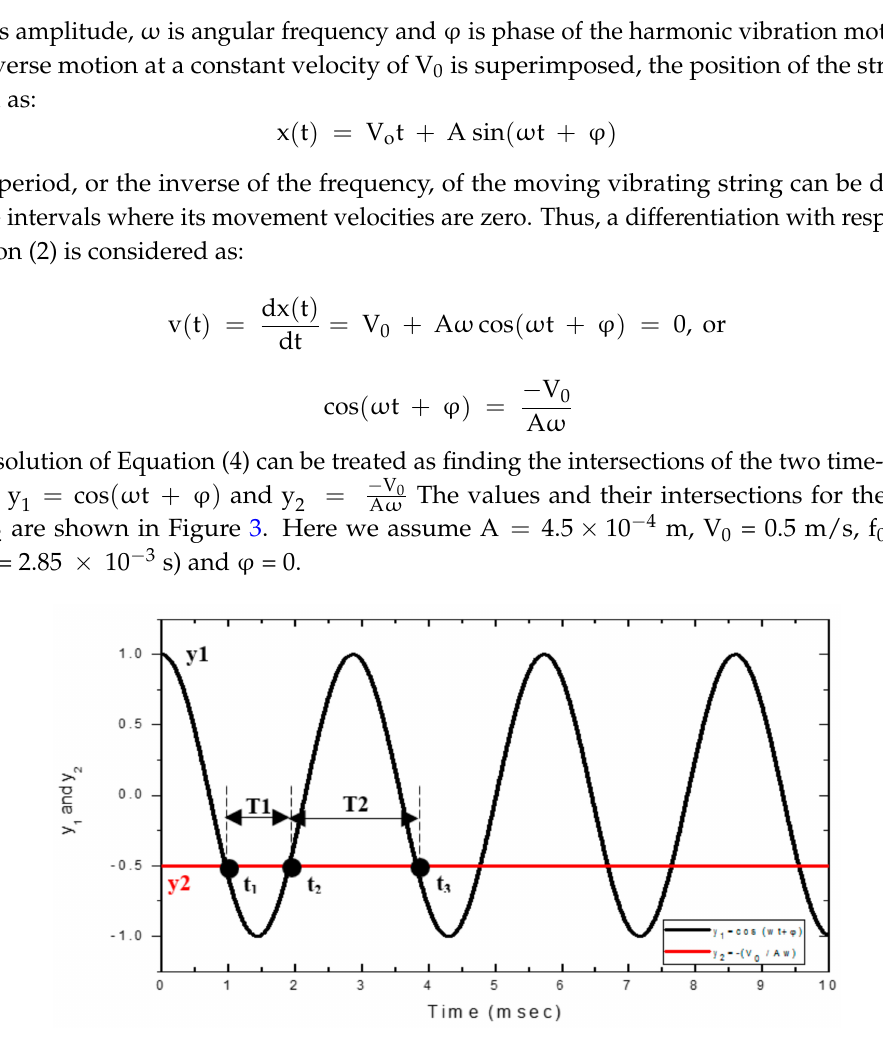
Figure 3. Functions y 1 and y 2 and their